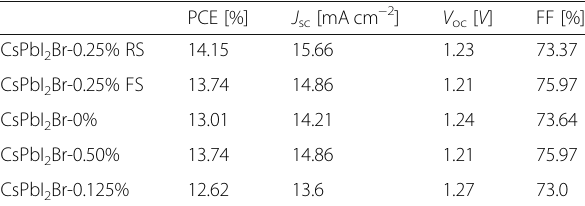
Table 1 Comparison of the device parameters of the perovskite solar cells based on different CsPbI 2 Br-ZnCl 2 -MnCl 2 films